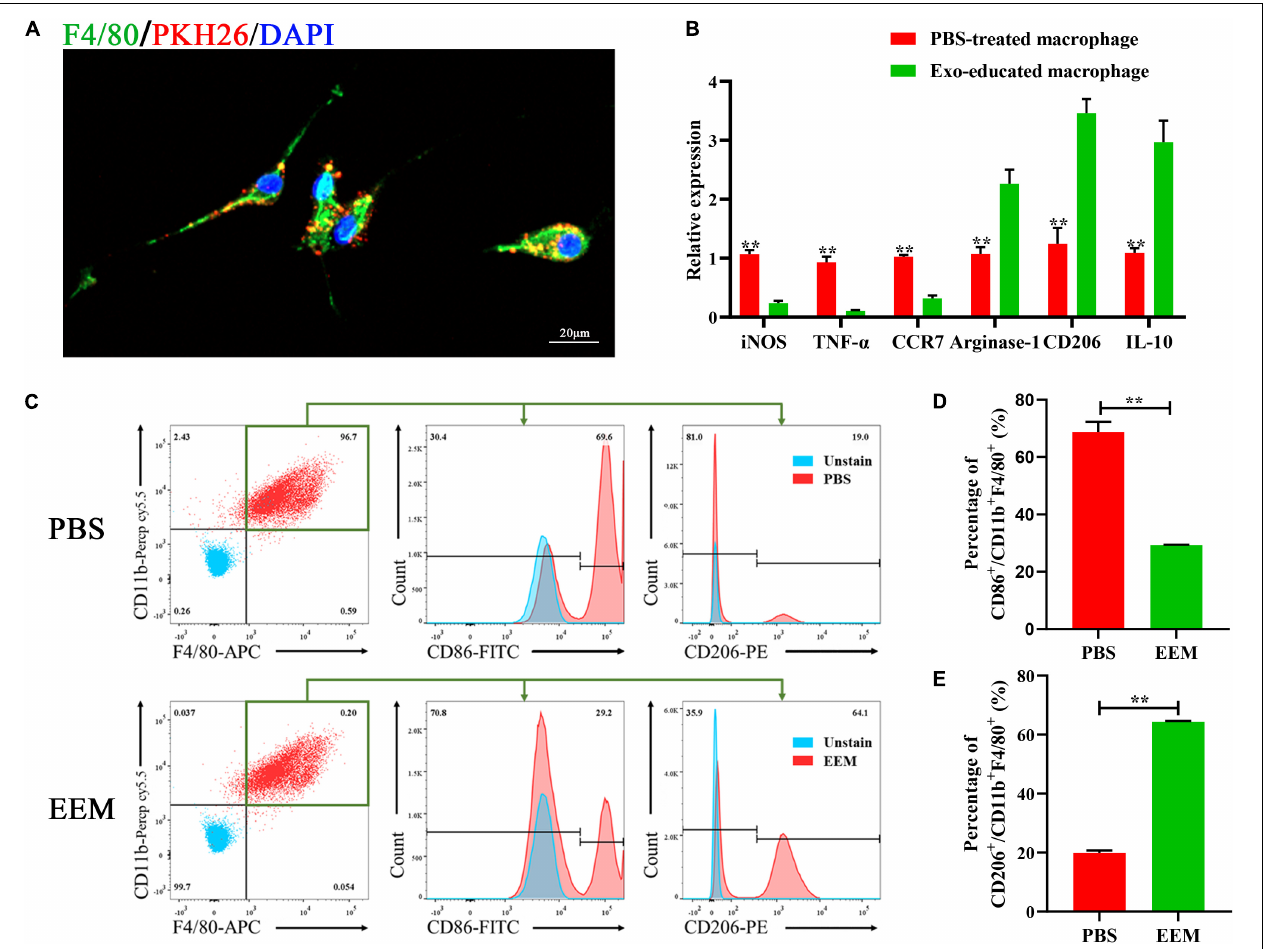
FIGURE 2 | Exosomes educate macrophages to become M2-like macrophages. (A) Analysis of cellular exosome uptake by macrophages. PKH26: red, DAPI: blue, F4/80: green. Scale bar: 20 µ m. (B) Macrophage mRNA was analyzed for the indicated M1 or M2 marker genes by RT-PCR (iNOS: t = 17.45, p < 0.01; TNF- α : t = 14.19, p < 0.01; CCR7: t = 21.55, p < 0.01; Argnase-1: t = 7.714, p < 0.01; CD206: t = 10.61, p < 0.01; IL-10: t = 8.737, p < 0.01; n = 3 biological replicates for each group. (C) Changes in surface antigen expression in educated macrophages was analyzed by flow cytometry. (D) Quantitation of percentage of CD86 + /CD11b + F4/80 + of (C) ( t = 19.39, p < 0.01, n = 3 biological replicates for each group). (E) Quantitation of percentage of CD206 + /CD11b + F4/80 + of (C) ( t = 80.15, p < 0.01, n = 3 biological replicates for each group). The data are presented as the means ± SD, * p < 0.05, ** p < 0.01, NS = Not